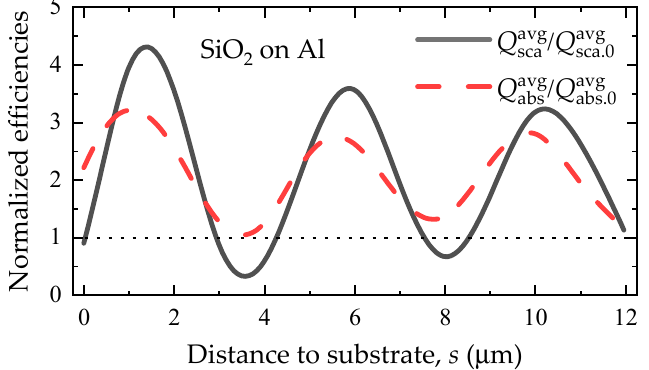
Figure 6. The touching substrate strongly enhanced the absorption within the particle, which arose from the interaction between the induced and image charges. With the increased distance, however, it was intriguing to observe a periodic fluctuation of the normalized efficiencies, which was dominated by the role of standing waves. According to Refs. [25,26,63], the period of the oscillating far-field cross sections can be analyzed by the phase term of exp ( − 2 ikd cos ϑ ) , where ϑ is the incident angle, k = 2 π / λ is the wavenumber, and d = a + s . Therefore, the optical properties will oscillate with the period of k ( a + s ) cos ϑ = π [26]. Taking the wavelength at the averaged value of 11 µ m, we theoretically calculated the period of the distance ∆ s ≈ 4.5 µ m, which agreed well with the numerical results in Figure 6. It should also be noted that the oscillated amplitudes damp with the increasing distance, which implies a gradually weakening role of the standing waves on the particle.